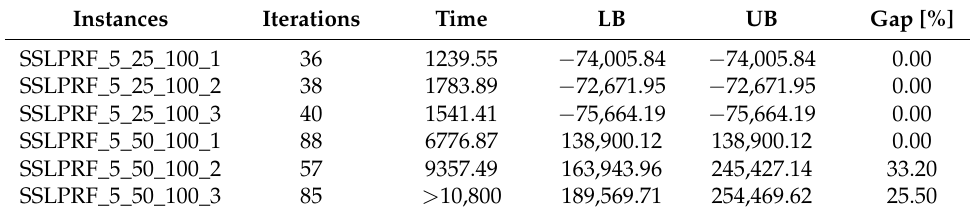
Table A5. Computational results for DSP on SSLPR.